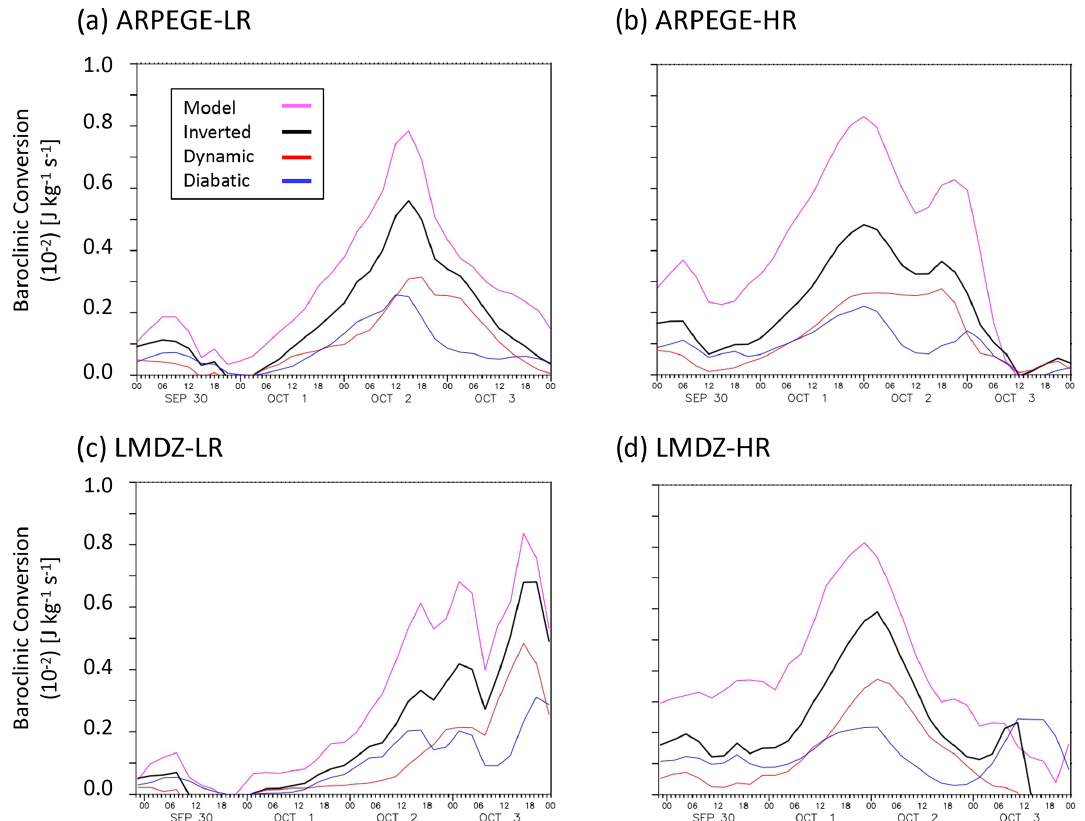
Figure 7. The evolution of the average baroclinic conversion in a 10 ◦ × 10 ◦ box around the minimum pressure of the Stalactite cyclone for (a) ARPEGE-LR, (b) ARPEGE-HR, (c) LMDZ-LR, and (d) LMDZ-HR. The magenta line is for the baroclinic conversion calculated with the model ω , the black line is the total inverted ω , the red line is the inverted ω from dynamical processes, and the blue line is the inverted ω from diabatic processes. All hindcasts were initiated at 00:00UTC 29 September 2016, and average times are defined, subtly, differently in LMDZ and ARPEGE, hence the 1.5h extension in LMDZ plots. Maximum point values of baroclinic conversion are shown in Fig.